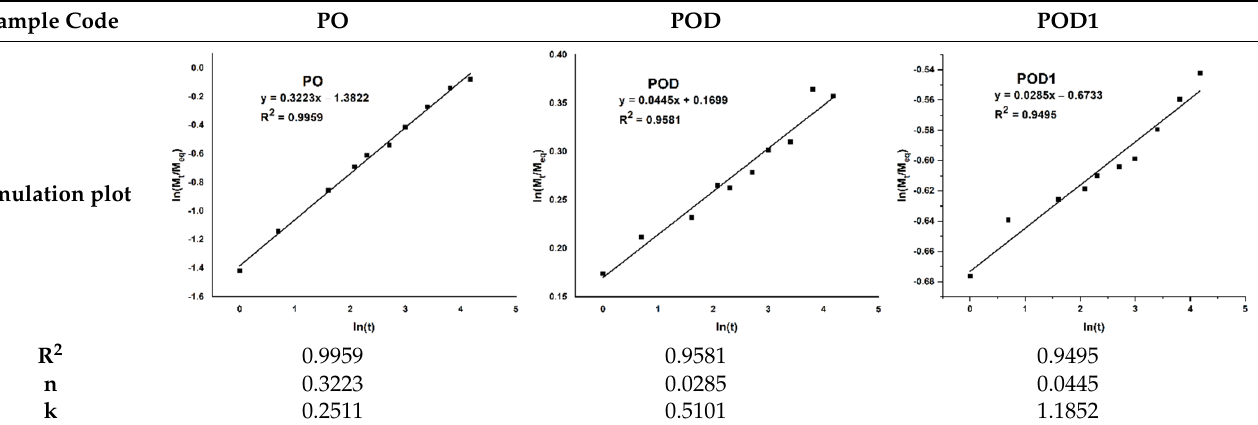
Table 1. Plots illustrating the goodness of the fit of the Korsmeyer–Peppas equation on the experi- mental data and the resulting parameters: the correlation coefficient ( R 2 ), the exponent ( n ) and the Korsmeyer–Peppas constant ( k ).